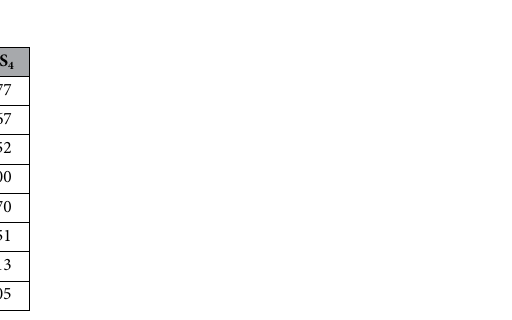
Figure 1. Errors for the transition energies of the first four excited states between CCSD and the eight different DFT methods for Zn 2 O 2.